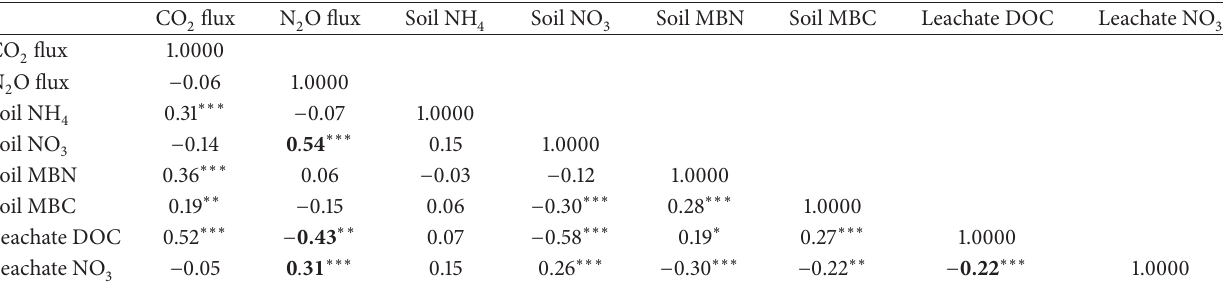
Table 5: Correlations between C and N losses via gaseous flux or in leachates and ancillary soil measurements, averaged from measurements ( 𝑛 = 144) taken at regular intervals during a 20 wks incubation study from microcosms filled with riparian soil with earthworms . Values are Spearman’s rank order coefficients ( 𝜌 ), with ∗ , ∗∗ , and ∗ ∗ ∗ indicating significant correlations at 𝑃 < 0.05 , 0.01, and 0.001, respectively, and NS = nonsignificant correlation.